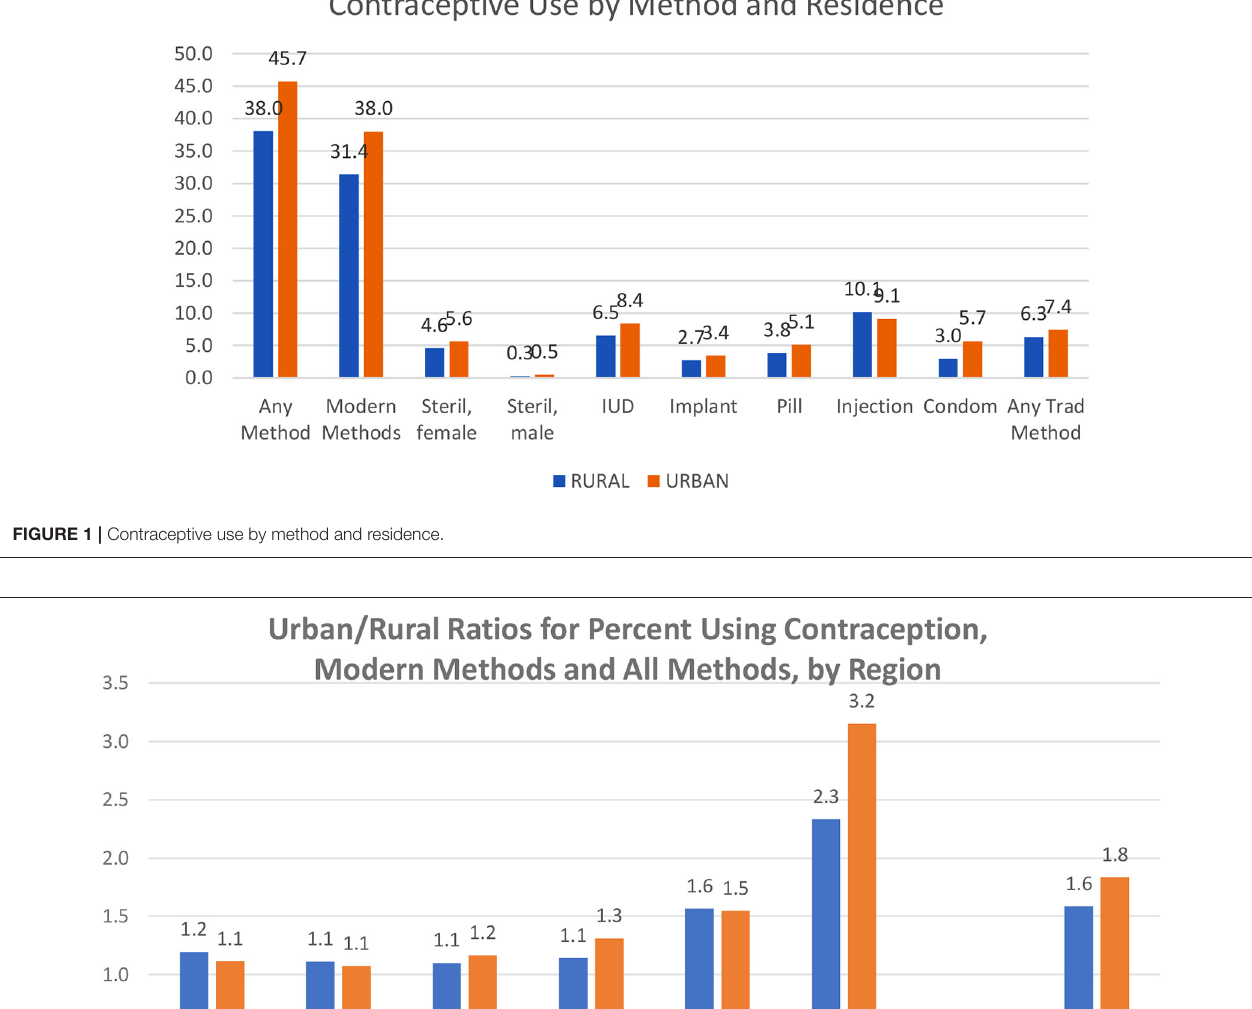
countries, just for the urban sector and just for married and in-union